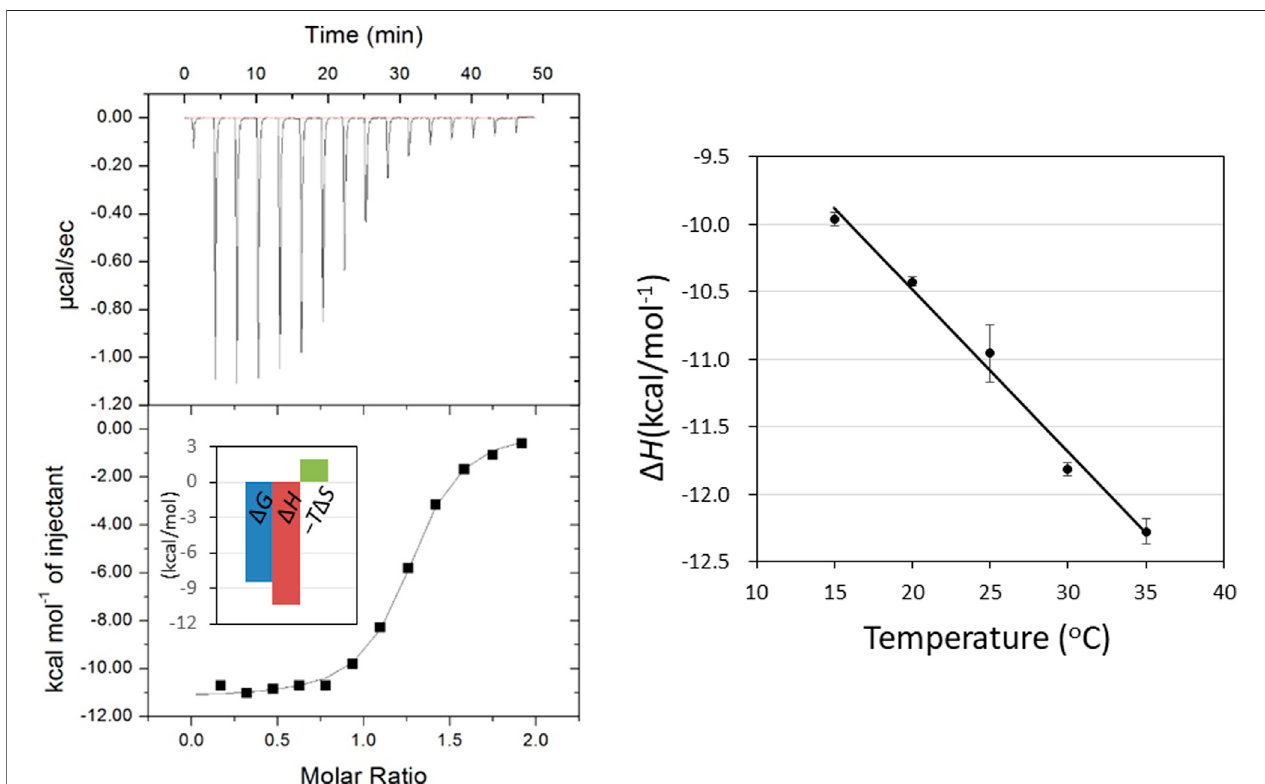
FIGURE 2 | ITC thermogram (upper) and theoretical fi t to the experimental data (lower) for binding of GN 3 M at 20 ° C. Inset shows the bar diagram of the thermodynamic parameters (A) . Temperature dependence of GN 3 M binding to HEWL; the plot of Δ H ° versus temperature yielded a change in the heat capacity ( Δ C p ° ) based on the slope of the line. The Δ C p ° value was calculated to be − 120.2 cal/ K · mol (B)